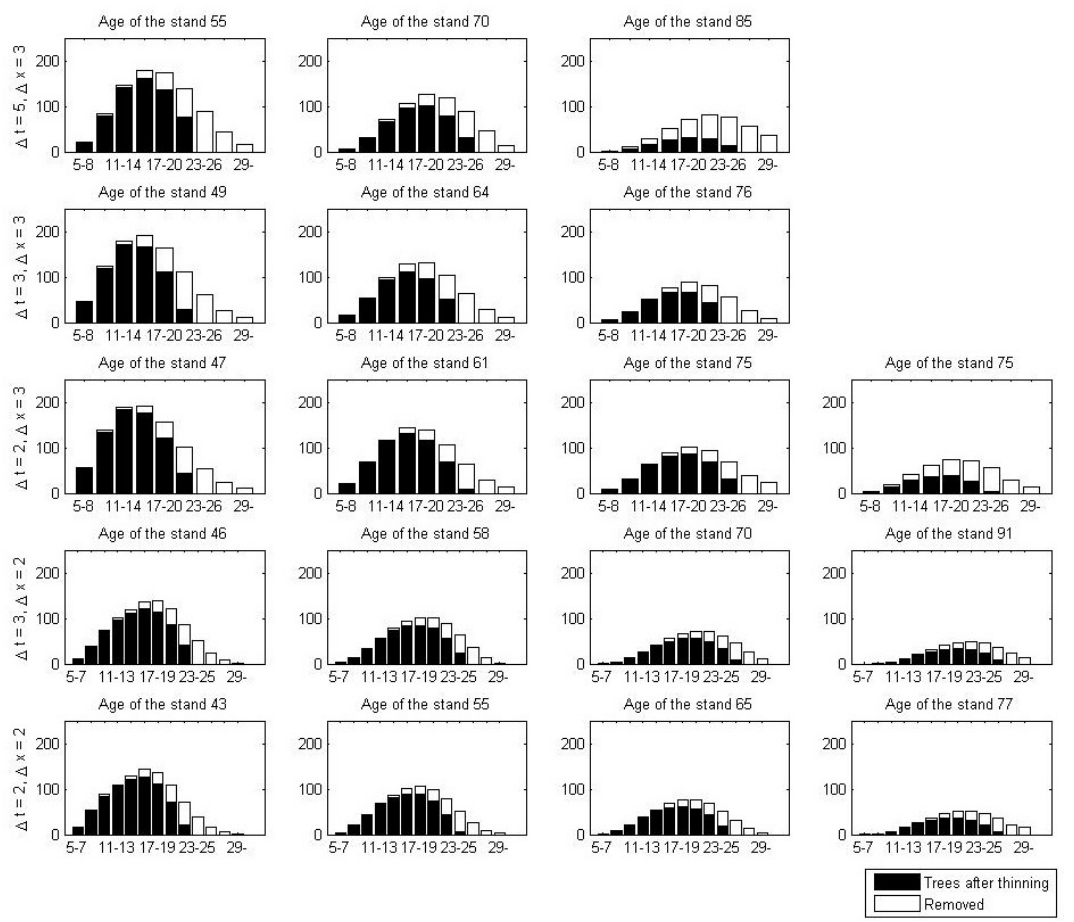
Figure 1. Diameter distributions associated with optimal thinnings of problem (14) with state equation approximated by explicit scheme (7). Numbers (e.g., 5–8, 11–14) represent diameter in